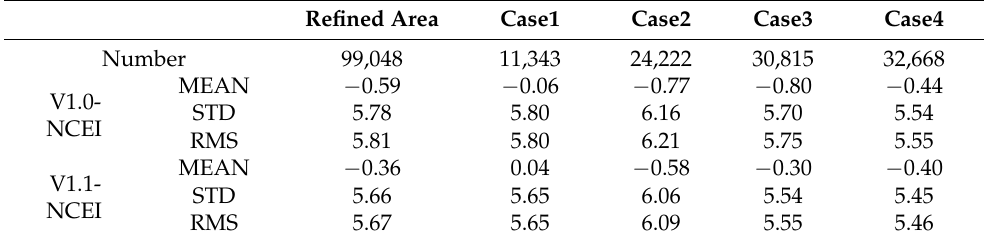
Table 7. Statistics of differences between gravity models and the testing shipborne data (in mGal). Refined Area Case1